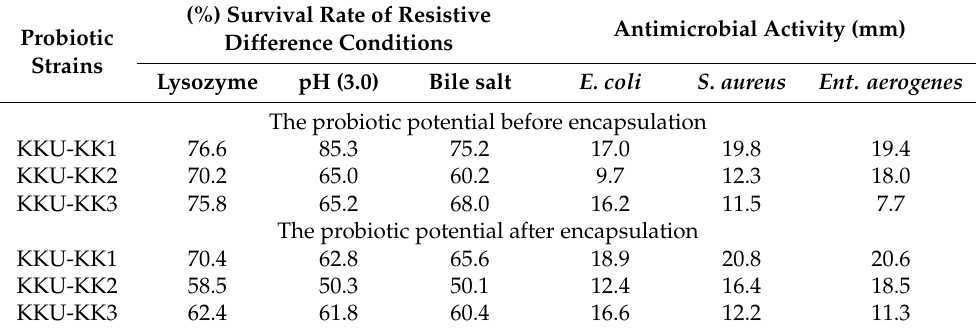
Table 2. Probiotic characteristics, antimicrobial activities, and the percentage of survival rates of different Lactobacillus species of the before and after encapsulated probiotic starter cultures. (%) Survival Rate of Resistive Antimicrobial Activity (mm) Probiotic Difference Conditions Strains Lysozyme pH (3.0) The probiotic potential before